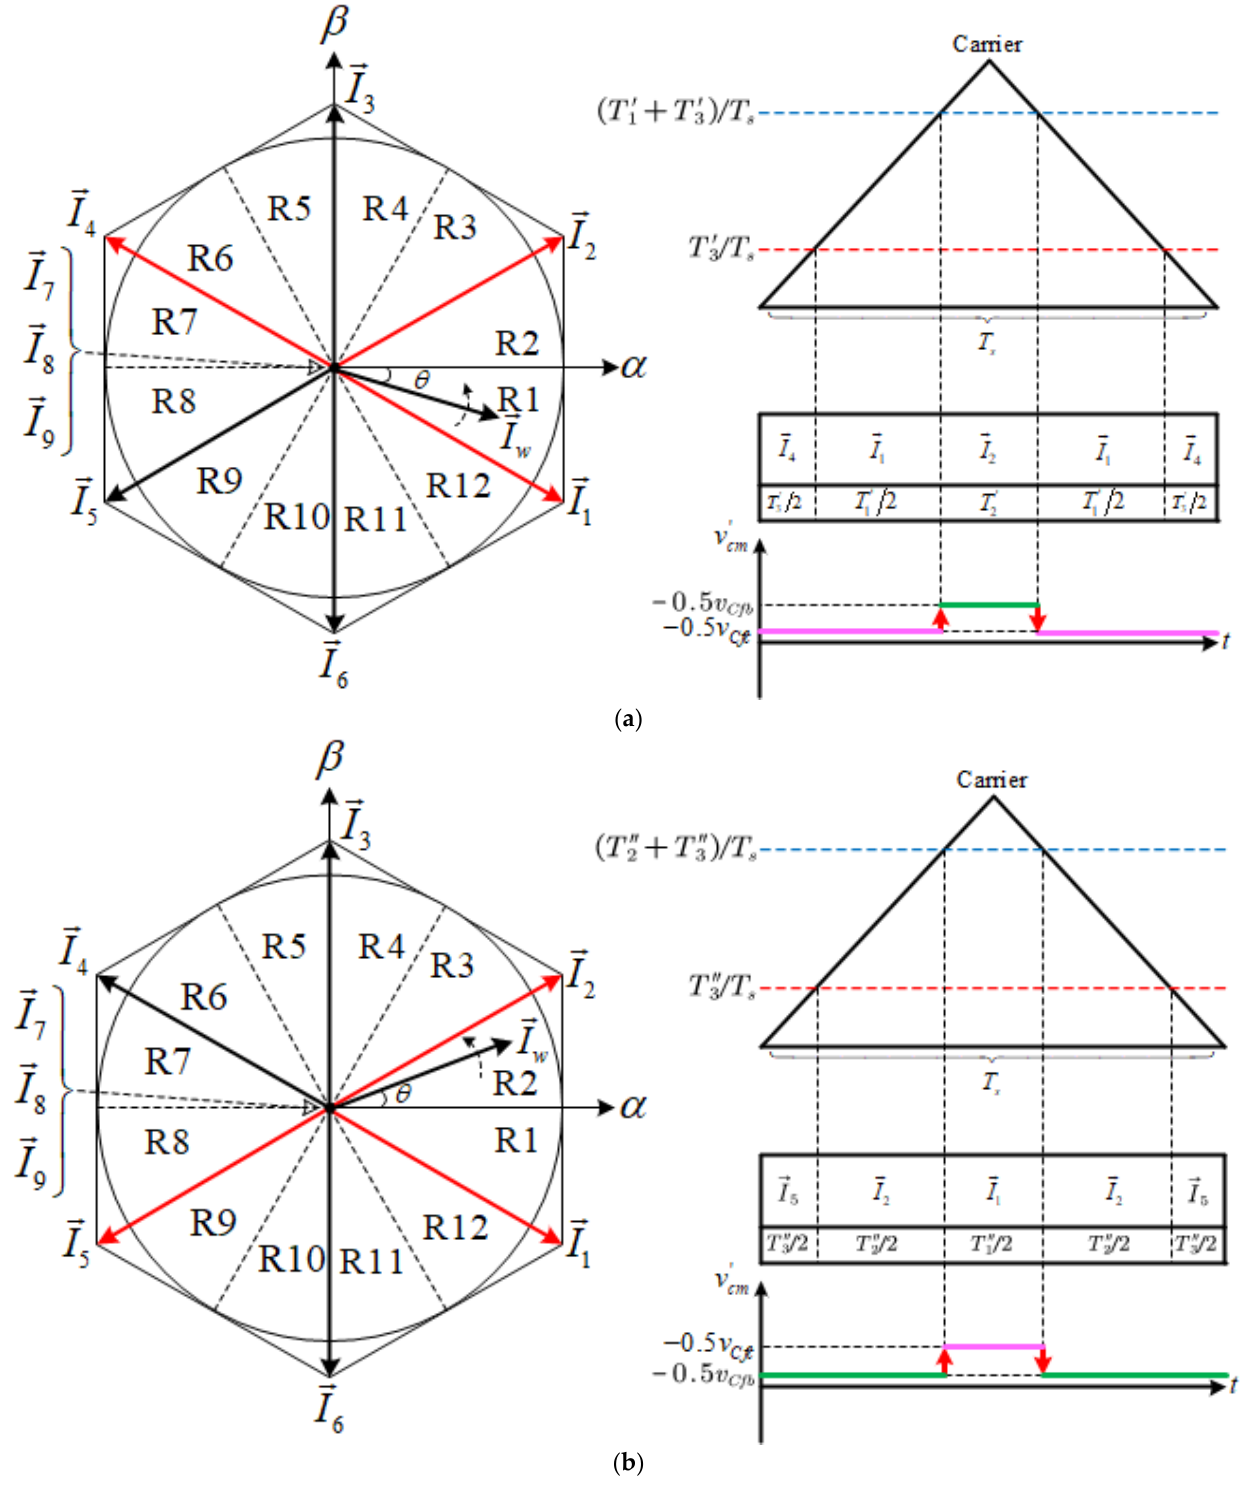
Figure 4. Five-segment sequence for AZS-SVM and region distribution: ( a ) region 1, and ( b ) region 2.